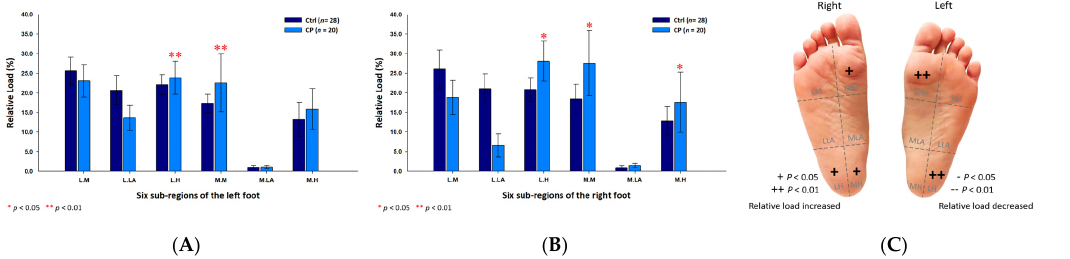
( C ) Figure 2. The percentage of six subregional relative loads of ( A ) left and ( B ) right feet in total stu- dents during static stance. The changes in pressure distribution are illustrated in ( C ) foot plantar diagram. Significant differences between the control group and the CP group were determined as *